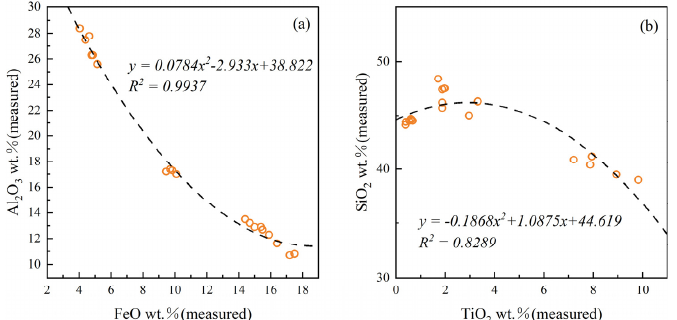
Figure 5. Correlations between ( a ) FeO and Al 2 O 3 and ( b ) TiO 2 and SiO 2 in the LSCC samples with 10–20 μ m grain sizes.